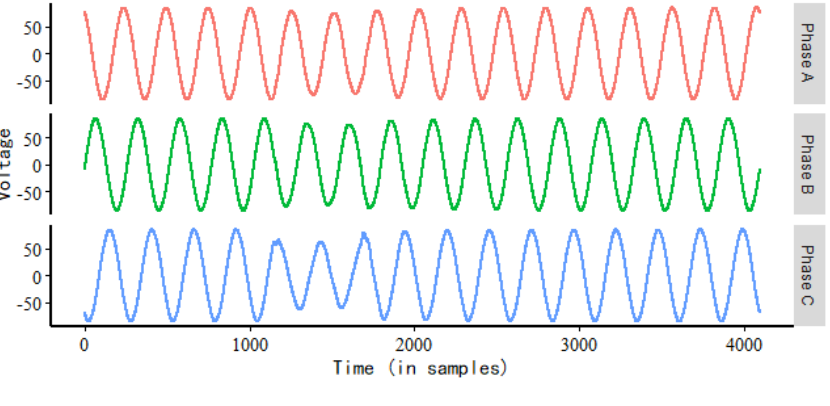
Figure 1. Voltage data (id 01).